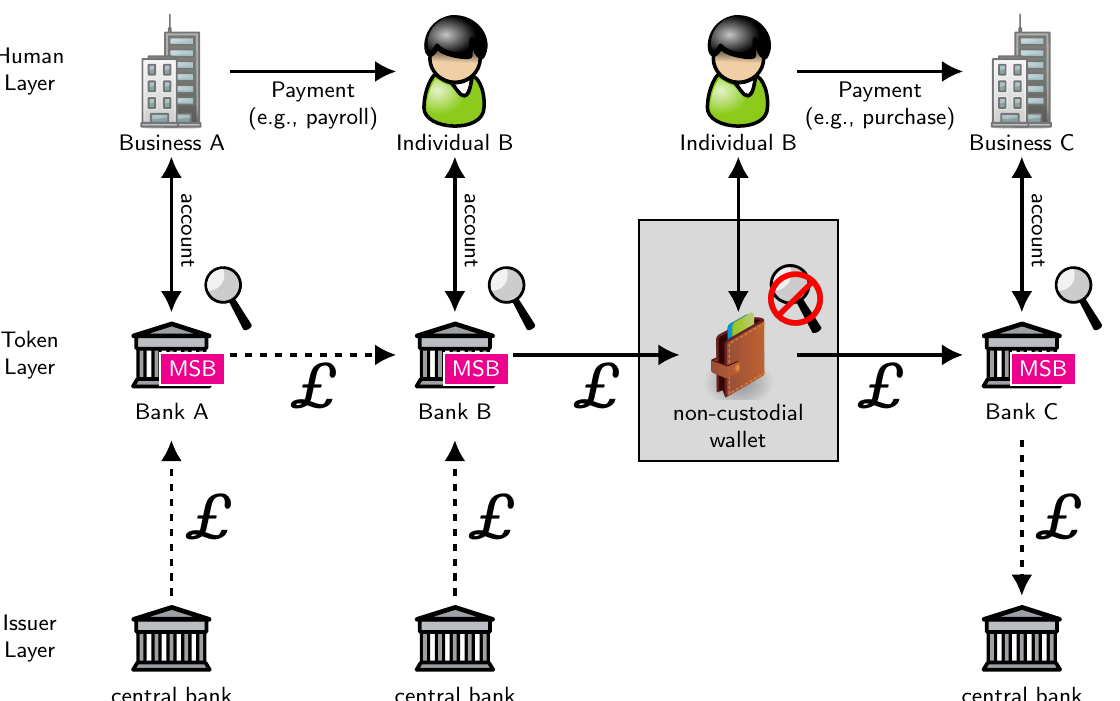
Figure 3. Schematic representation of a typical user engagement